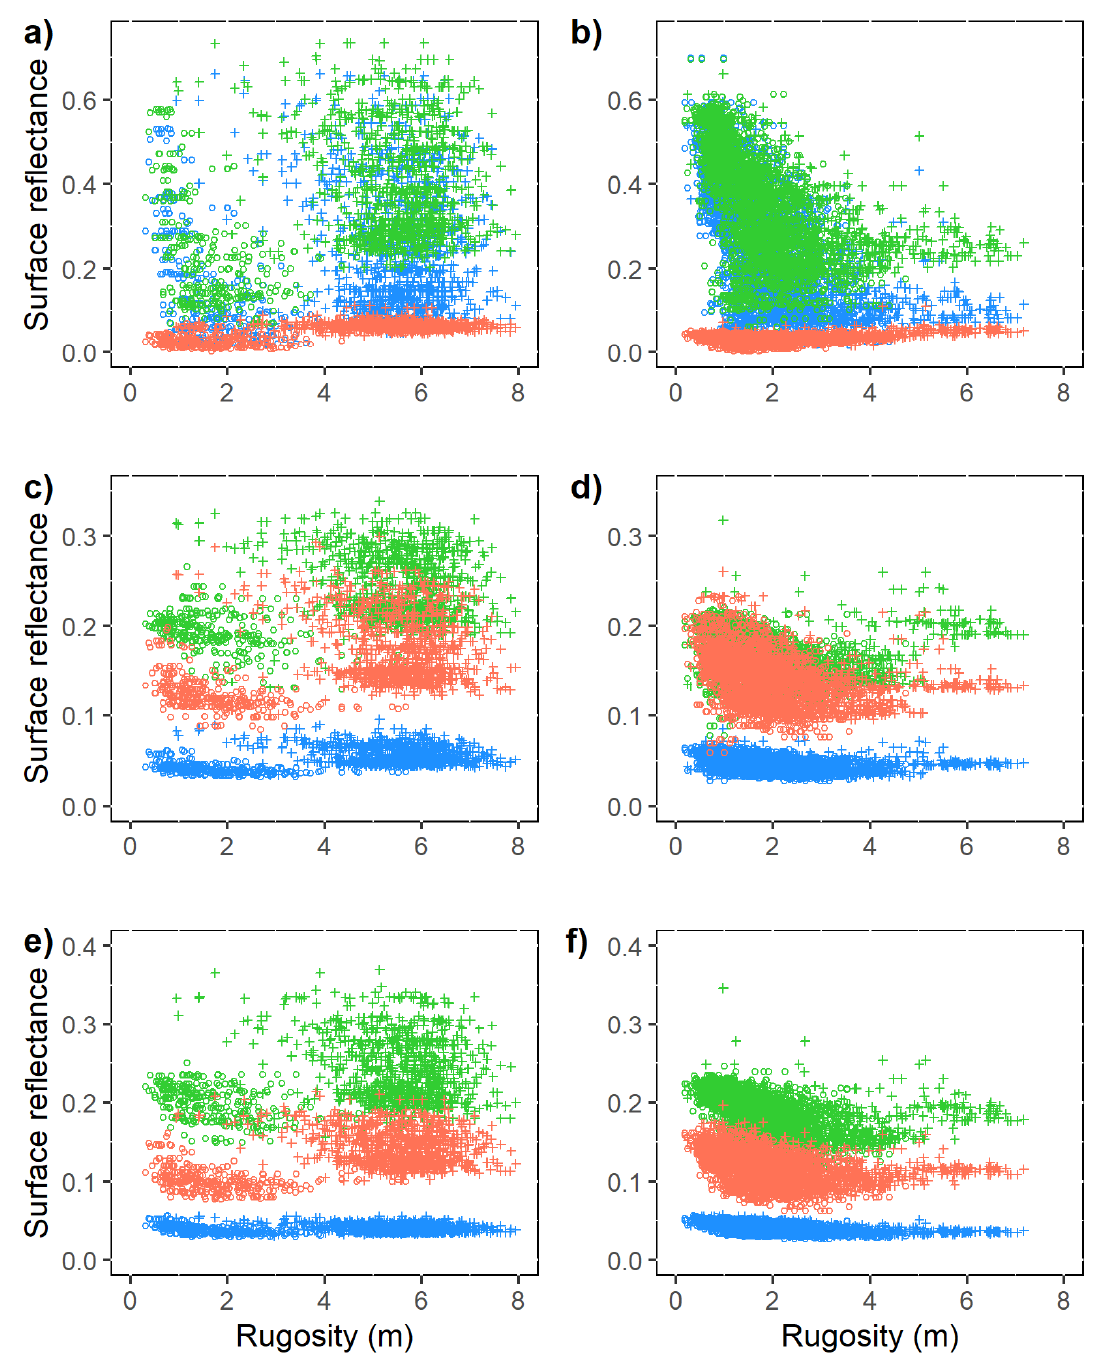
Figure 8. Relationships between surface reflectance (visible band in blue, near-infrared band in green, and shortwave infrared band in orange) and rugosity in March (upper panel), May (middle panel), and August (lower panel) 2014. Trees in the northern aspect are represented by an open circle, and in the southern aspect, by a cross symbol. Sub-plot ( a , c , e ) are for deciduous forests, while sub-plot ( b , d , f ) are for evergreen forests.